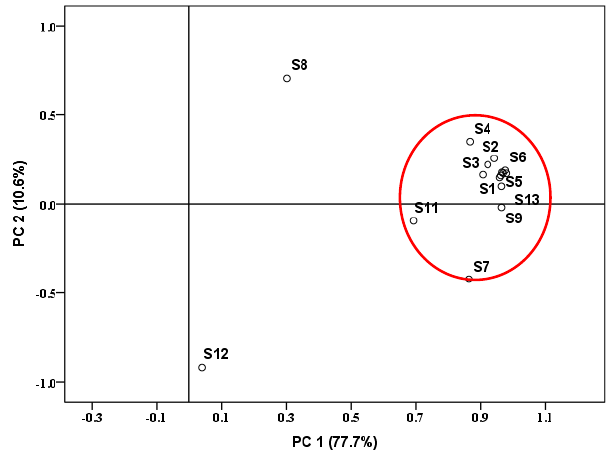
Figure 3. PCA score plot of the polychlorinated naphthalene profile of sediment samples.